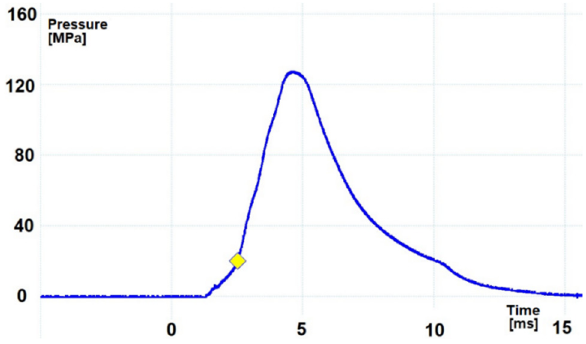
Figure 3. Example of pressure p ( t ) in the tube of a 98 mm mortar during firing.